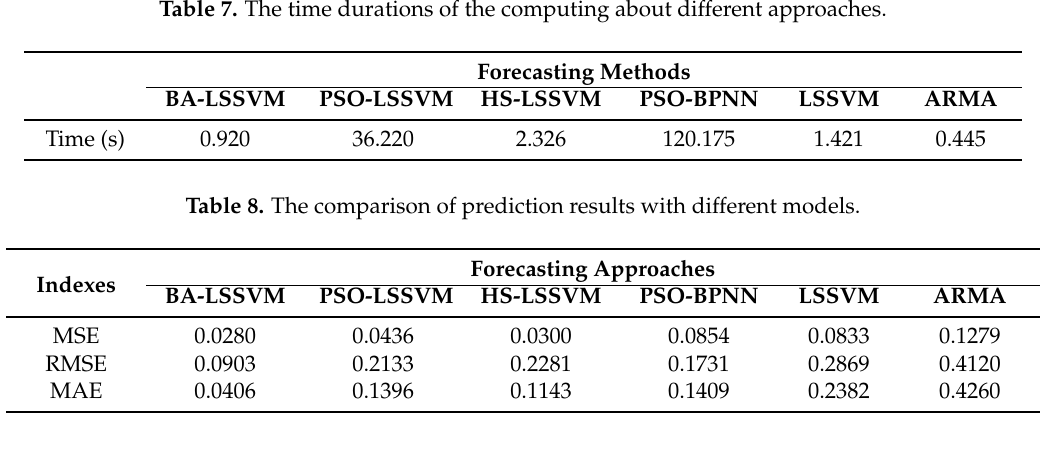
Table 7. The time durations of the computing about different approaches.